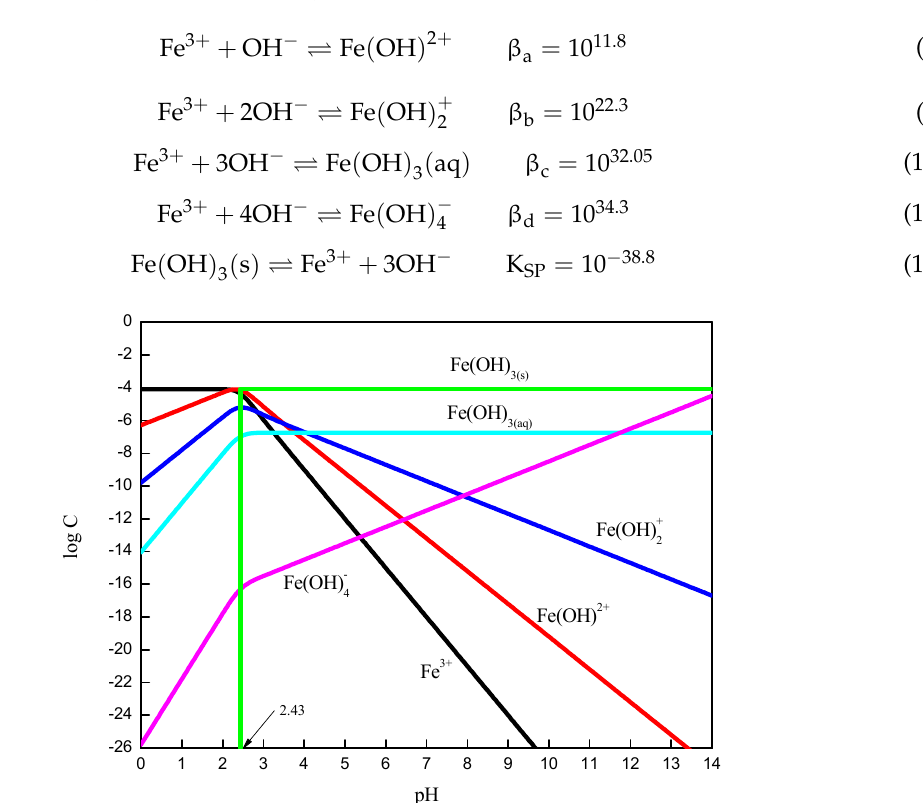
Figure 15. Species distribution diagram of Fe 3+ as a function of pH (Fe 3+ : 8 × 10 − 5 mol/L).